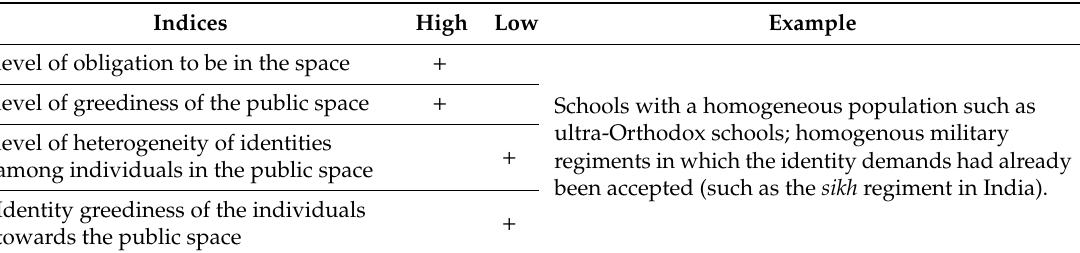
Table A11. Low potential confrontation.